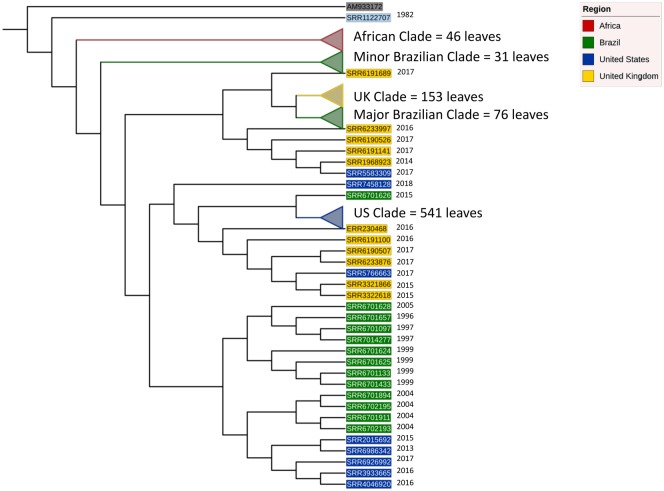
—Reduced phylogeny of S. Dublin. Ancestral state reconstruction using BEAST2 on core genes conserved major geographical clades. Clades are collapsed to aid in visualization of high-order tree architecture. The phylogeny is rooted to S. Enteritidis AM933172. Clades and leaf labels are colored respective to the region of isolation. Isolation date is listed to the right of leaves not collapsed into clades.